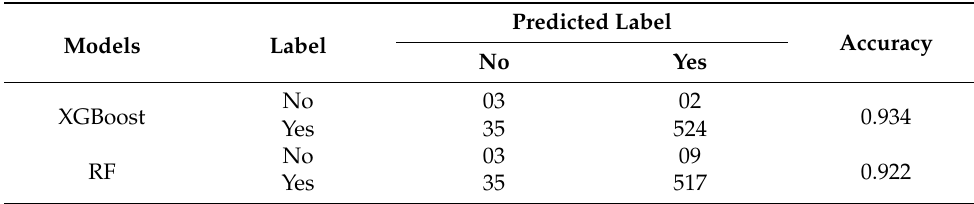
Table 4. Confusion matrix of XGBoost, and RF.